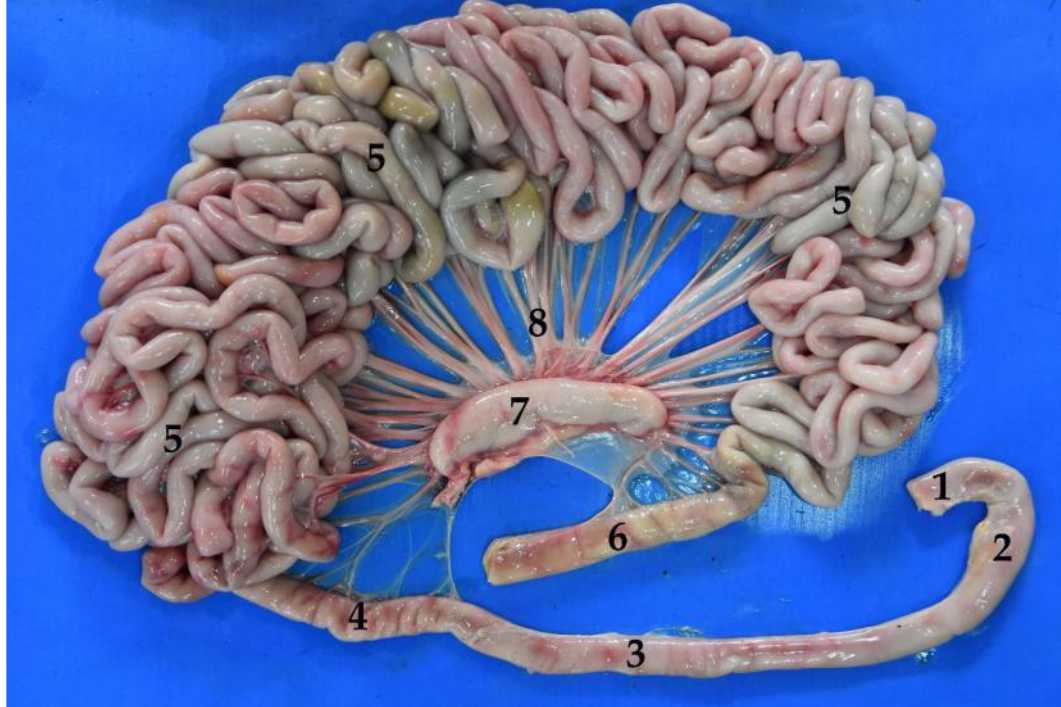
Figure 12. Isolated small intestine. Duodenum: ( 1 ) cranial part, ( 2 ) descending part, ( 3 ) transverse part, ( 4 ) ascending part; ( 5 ) jejunum; ( 6 ) ileum; ( 7 ) small intestine mesenteric lymph nodes; ( 8 ) mes- enteric vessels. ( 8 ) mesenteric